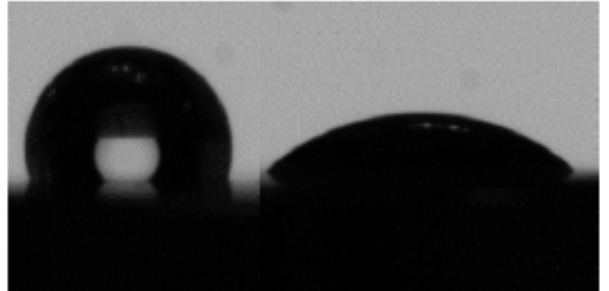
Figure 10. Image of the wettability of the grade IV NT SI sample with a drop of water (left) and with a drop of diiodomethane (right) on its surface. Table 9. Surface tensions and contact angles of the samples with TiO 2 coating. (GR IV: Titanium grade IV; GR V: Titanium grade V; T: SLA treated; NT: SLA non-treated; SI: Treated with TiO 2 film).